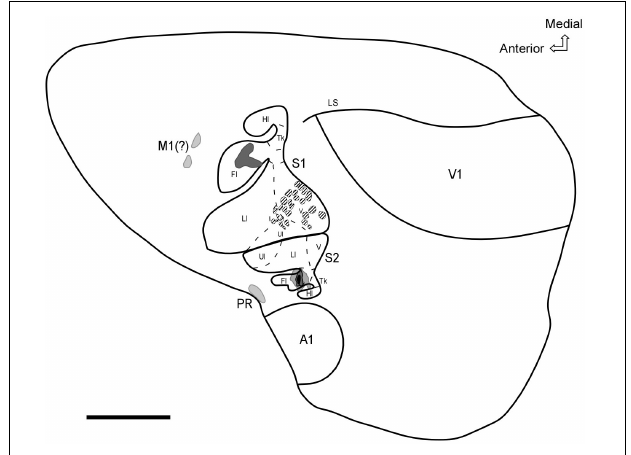
FIGURE 9 | Schematic diagram representing the general organization of sensory areas and feed forward projections from the forelimb representation in S2. The shaded areas represent projection targets in S1, the motor cortex, and PR. CO modules located in the face area of S1 are represented by hatched areas. Scale bar: 3 mm. Fl, forelimb; Hl, hindlimb; Ll, lower lip; N, nose; Tk, trunk; Ul, upper lip; V, vibrissae; A1, Primary auditory cortex; V1, primary visual cortex; LS, lateral